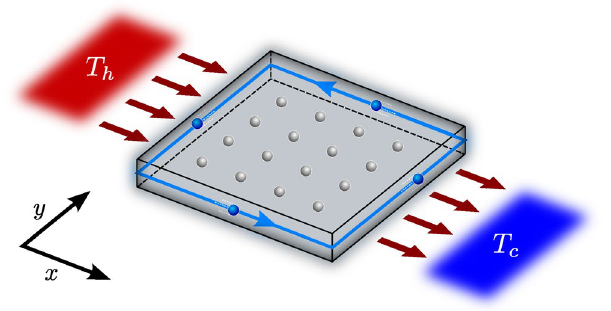
Figure 1. Schematic arrangement considered throughout this work. A Hofstadter boson system is set in contact with two oppositely sited thermal baths at respective temperatures T h (hot bath) and T c (cold bath). As a result, exotic chiral currents are induced on the system. The brown arrows show the direction of